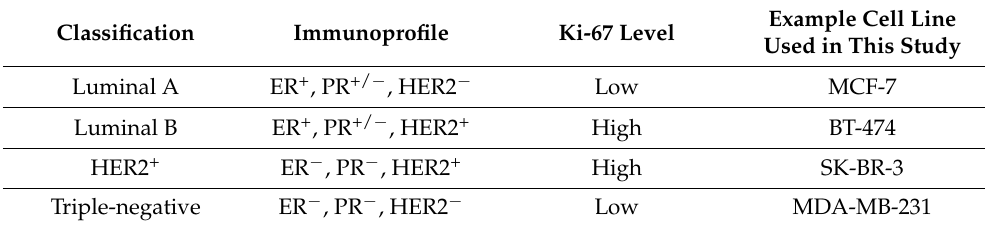
Table 1. Classification of Breast Cancer Cell Lines and Their Characteristics. Four different breast cancers and their categorization based on receptor type are